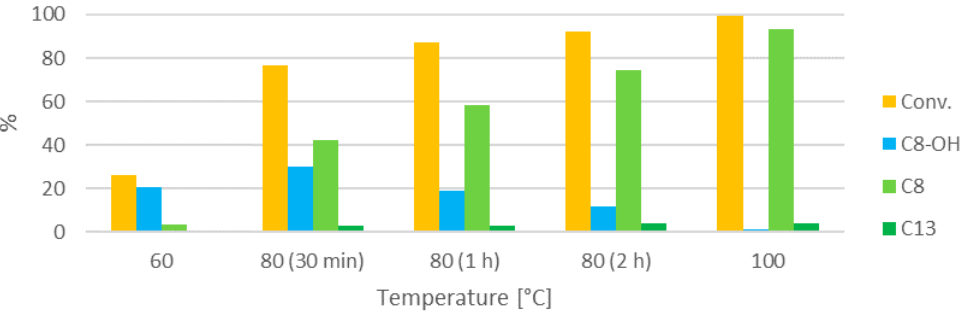
Figure 8. Influence of the reaction temperature (30 min, furfural:HT 2:1, 0.21 M).